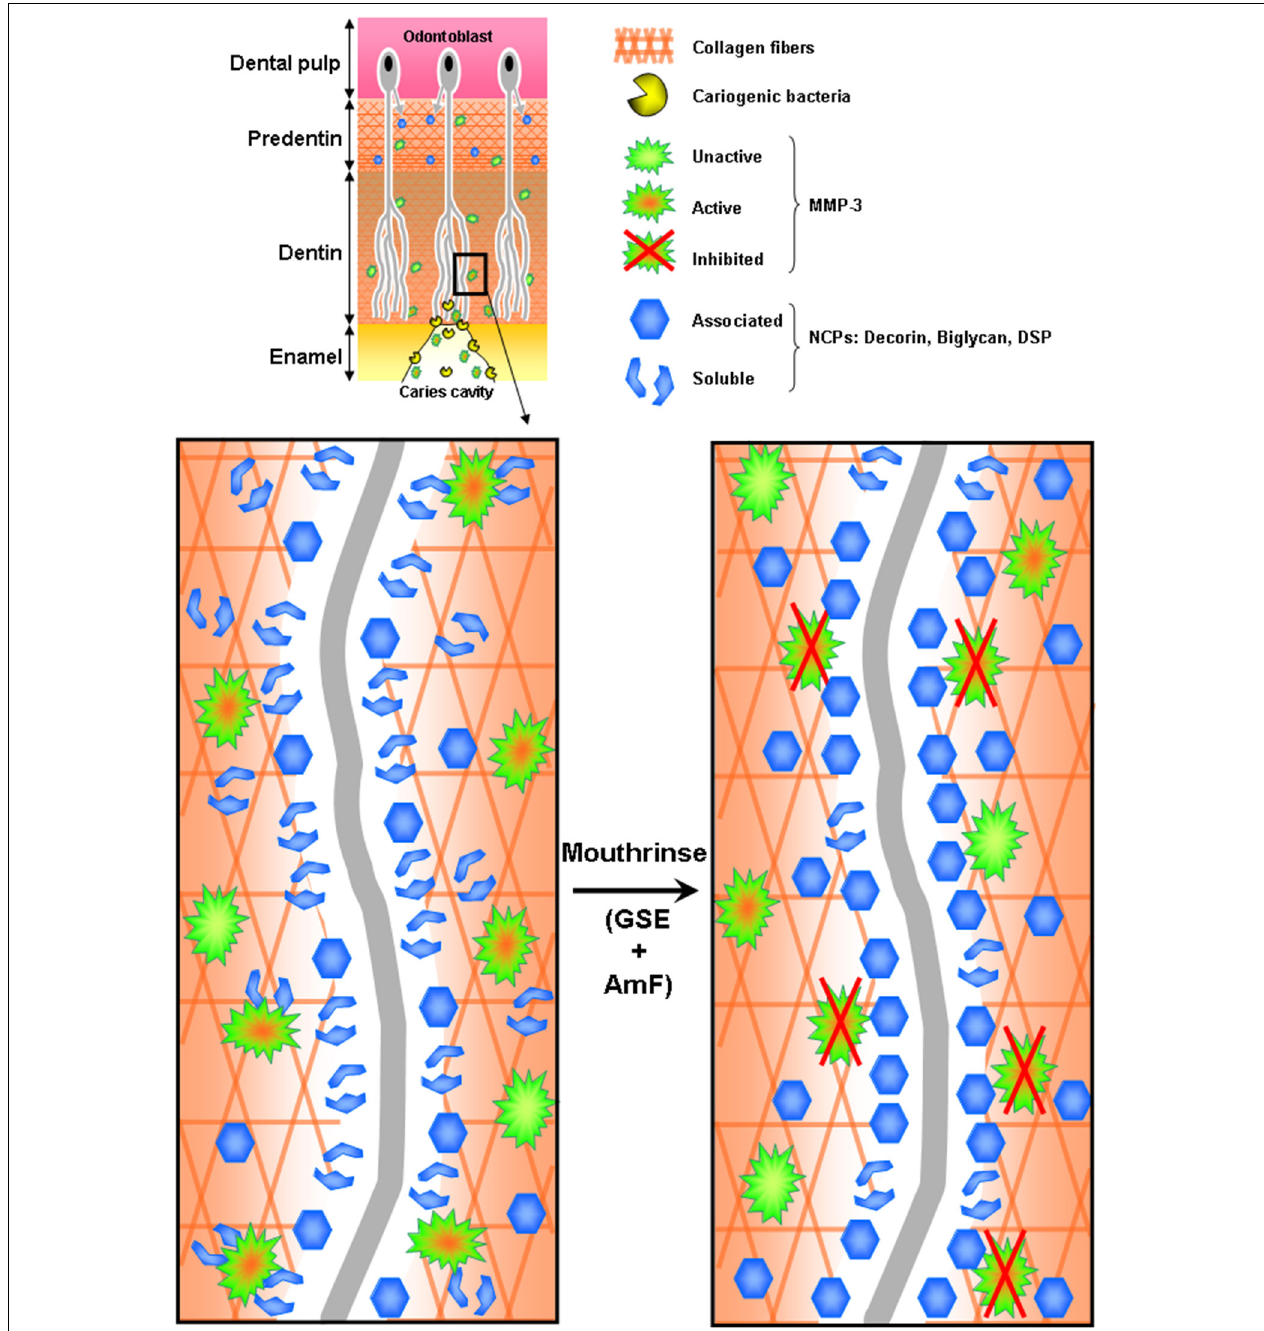
FIGURE 4 | Hypothetic representation of MMP-3 inhibition by the tested mouthrinse during the dentin carious process. Cariogenic bacteria present in the caries cavity release acids that demineralize the dentin matrix and activate host dentin or saliva-derived MMPs, including MMP-3. Activated